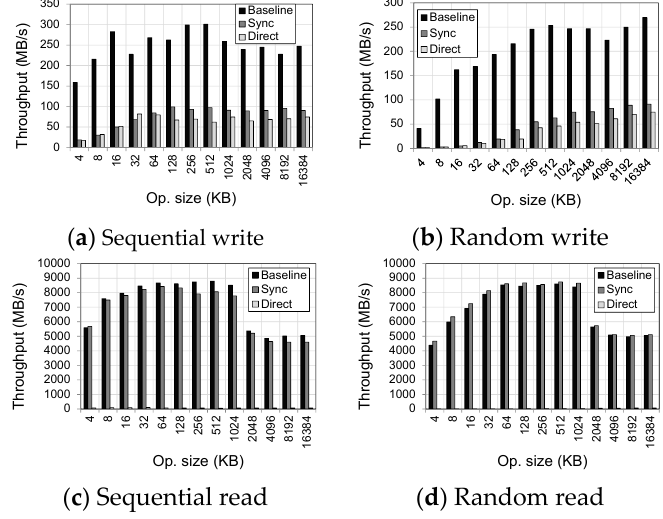
Figure 2. HDD performance under different I/O (input/output) modes.